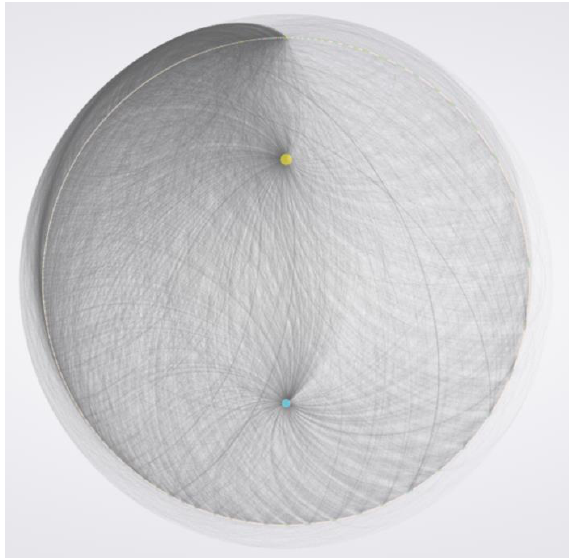
Figure 4. A bipartite social network graph by hashtag-user co-occurrences of 5212 nodes (3672 users, 1540 hashtags) and 48,396 undirected edges (co-occurrences); Spatialization: Dual Circle Layout; Size: Weighted Degree; Color: Modularity Class 3 .